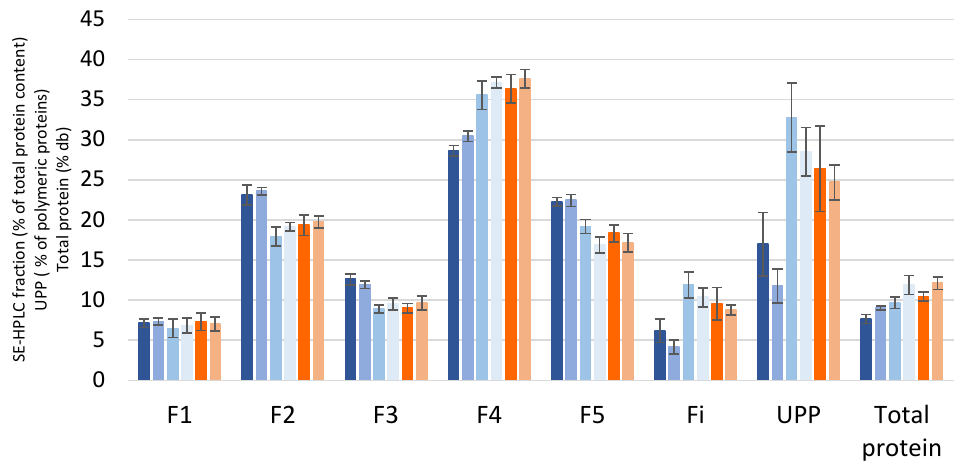
Figure 4. Comparison of the protein fractions measured on ground grains, cultivated in zero (ZI)- or low (LI)-input conditions and harvested in 2016 (H2016) or 2017 (H2017) in Mauguio. For each fraction, the means and error bars (SD) of the two groups of varieties are compared: IND = varieties recommended by the industry; FAR = varieties used by the farmers making pasta.